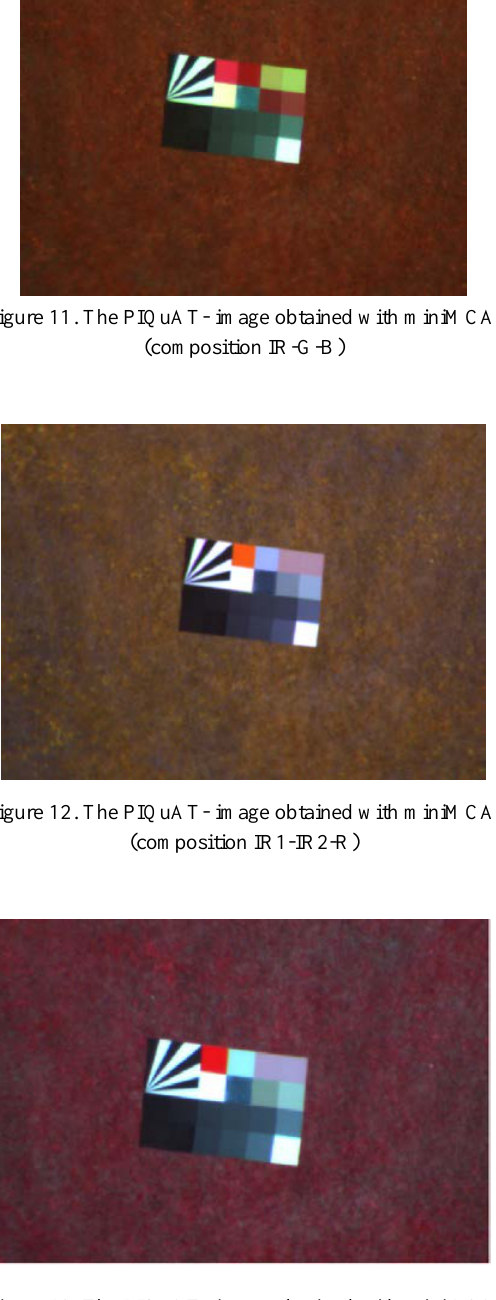
Figure 13. The PIQuAT- image obtained with miniMCA, (composition